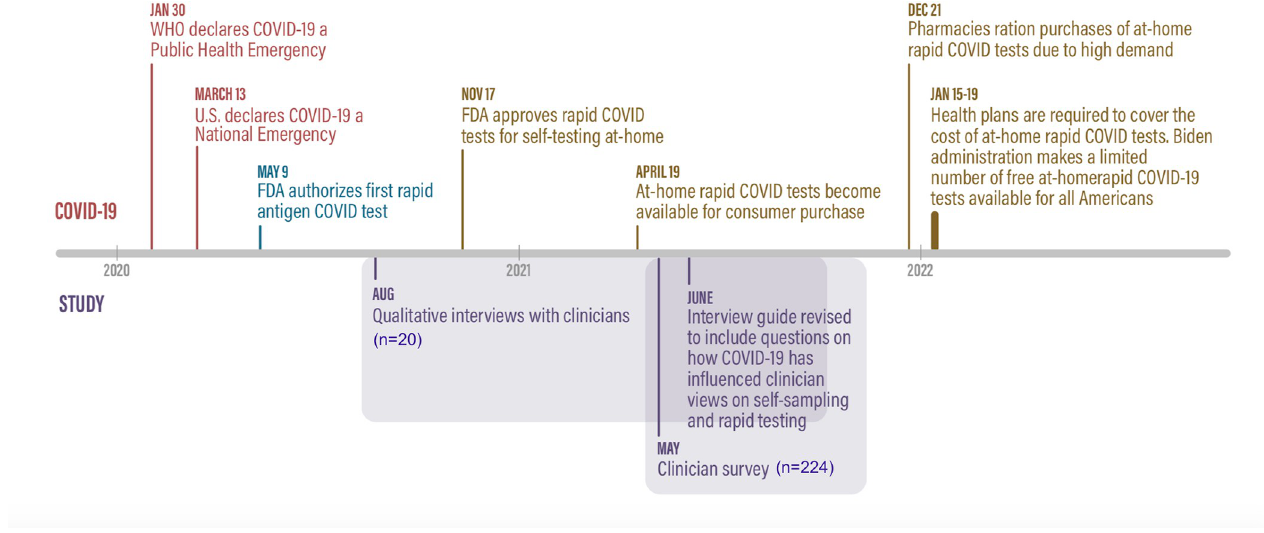
Fig 1. Timeline of study and COVID rapid testing